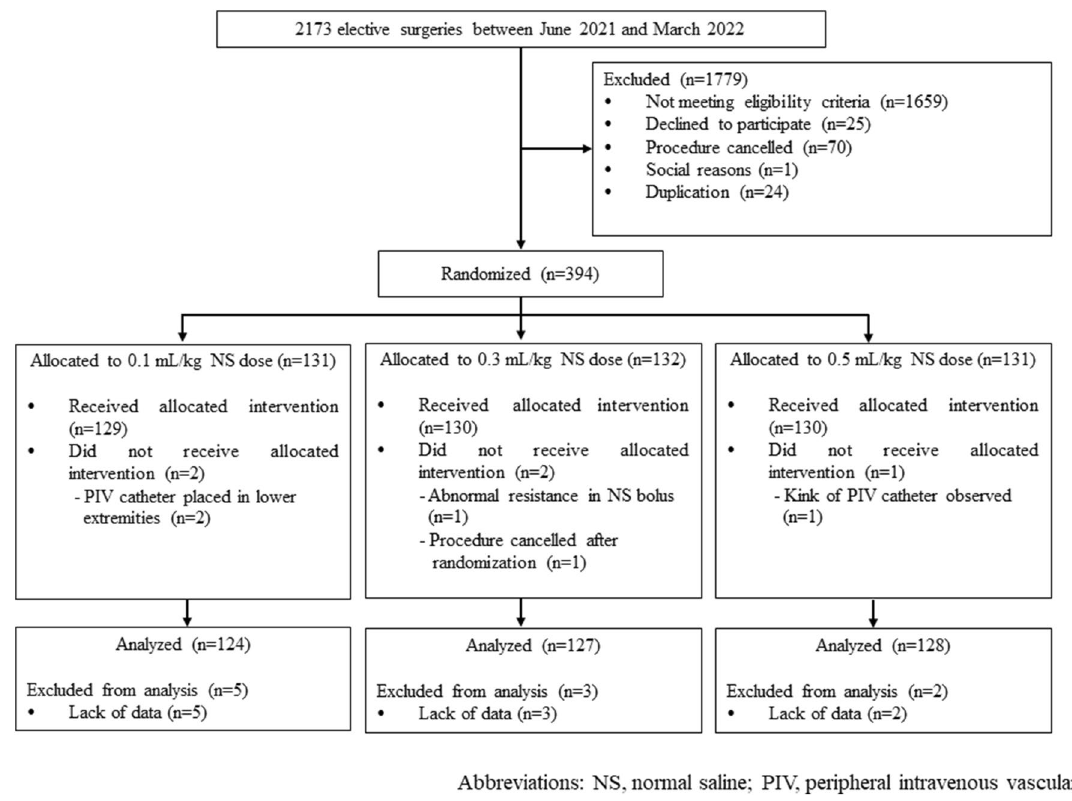
Figure 1. Flow diagram of participant selection. NS, normal saline; PIV, peripheral intravenous